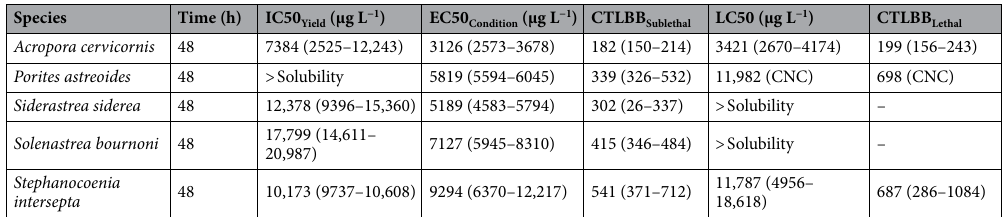
Table 2. Estimates of IC50 Yield , EC50 Condition , and LC50 (± respective 95% CIs) for 1-methylnaphthalene and associated calculated critical target lipid body burdens (± 95% CI) (µmol g −1 ). CNC could not calculate.